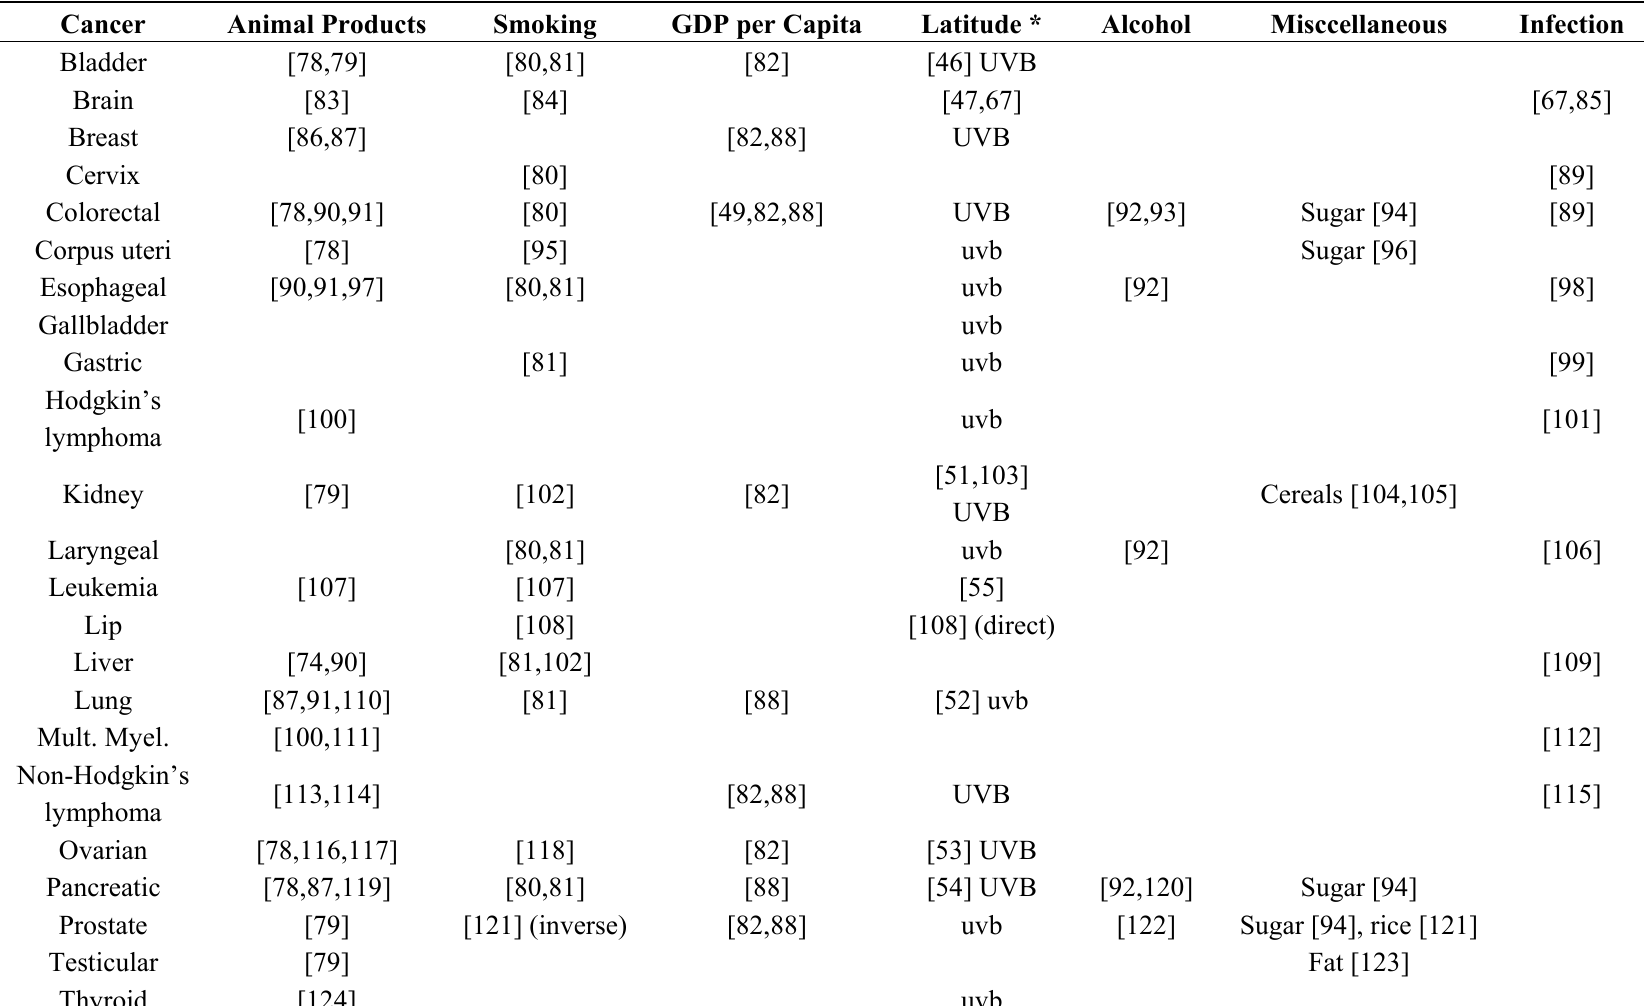
Table 5. Journal literature supporting findings in this